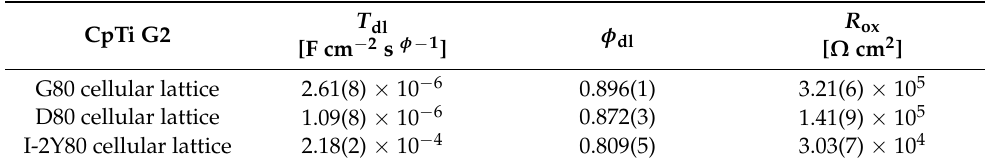
Table 4. The parameters with their standard deviations obtained using the equivalent electrical circuit model for corrosion shown in Figure 10c to approximate the experimental EIS data for the CpTi G2 cellular lattices with TPMS architecture in 0.1 M KOH solution saturated with O 2 at 25 ◦ C. R s was approximately equal to 11 Ω cm 2 for all measurements.